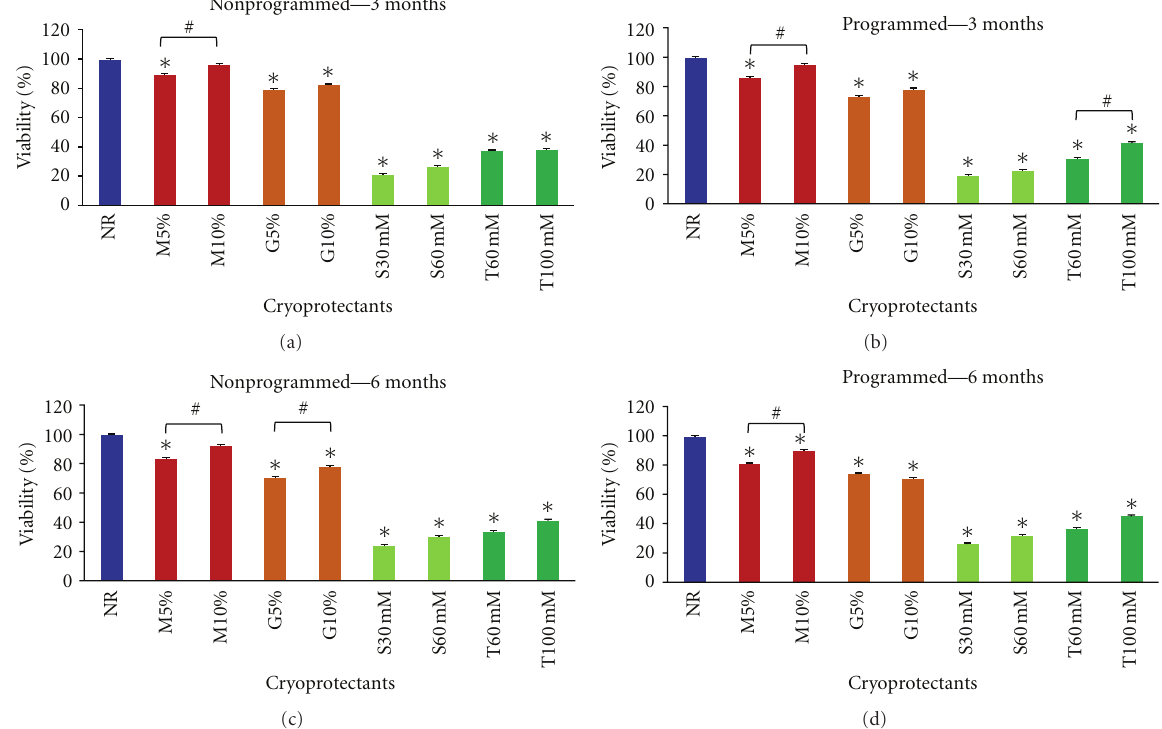
Figure 8: AFSCs viability comparing di ff erent cryoprotectants (Me 2 SO, glycerol, sucrose, and trehalose) and programmed and nonpro- grammed freezing protocols after 3 and 6 months. (a) viability in nonprogrammed method for 3 months; (b) viability in programmed method for 3 months; (c) viability in nonprogrammed method for 6 months; (d) viability in programmed method for 6 months. 10% Me 2 SO showed the higher viability rate similar to NR control in all cases. NR-AFSCs viability control measured before freezing procedure. M-Me 2 SO, G-glycerol, S-sucrose, and T-trehalose. Means were compared by one-way ANOVA Dunnett’s ( ∗∗∗ P < 0 . 05) and Bonferroni ( # P < 0,05) post